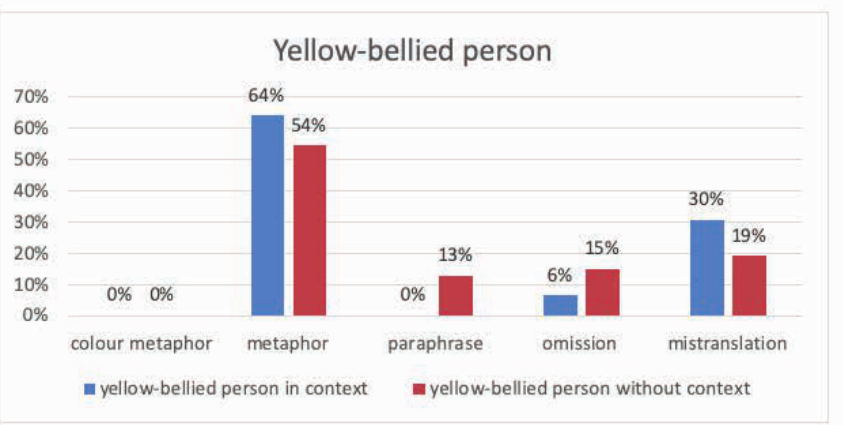
Figure 3: Translation strategies used for translating the colour metaphor yellow-bellied person in context and without